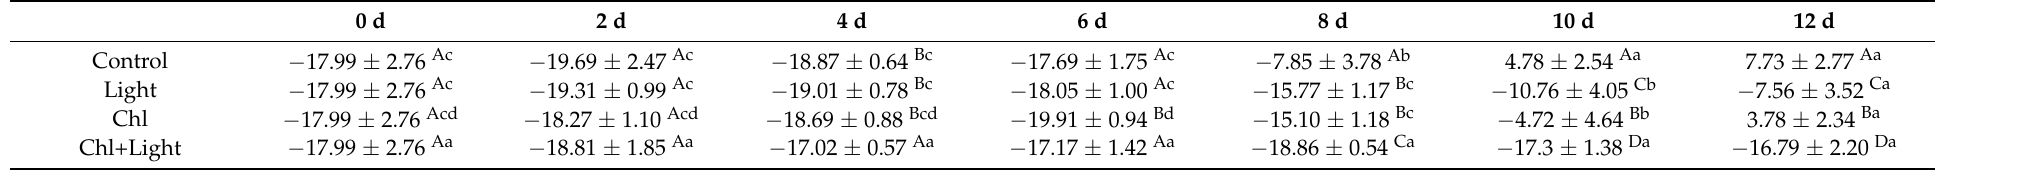
Table 2. The a* value of samples during storage.